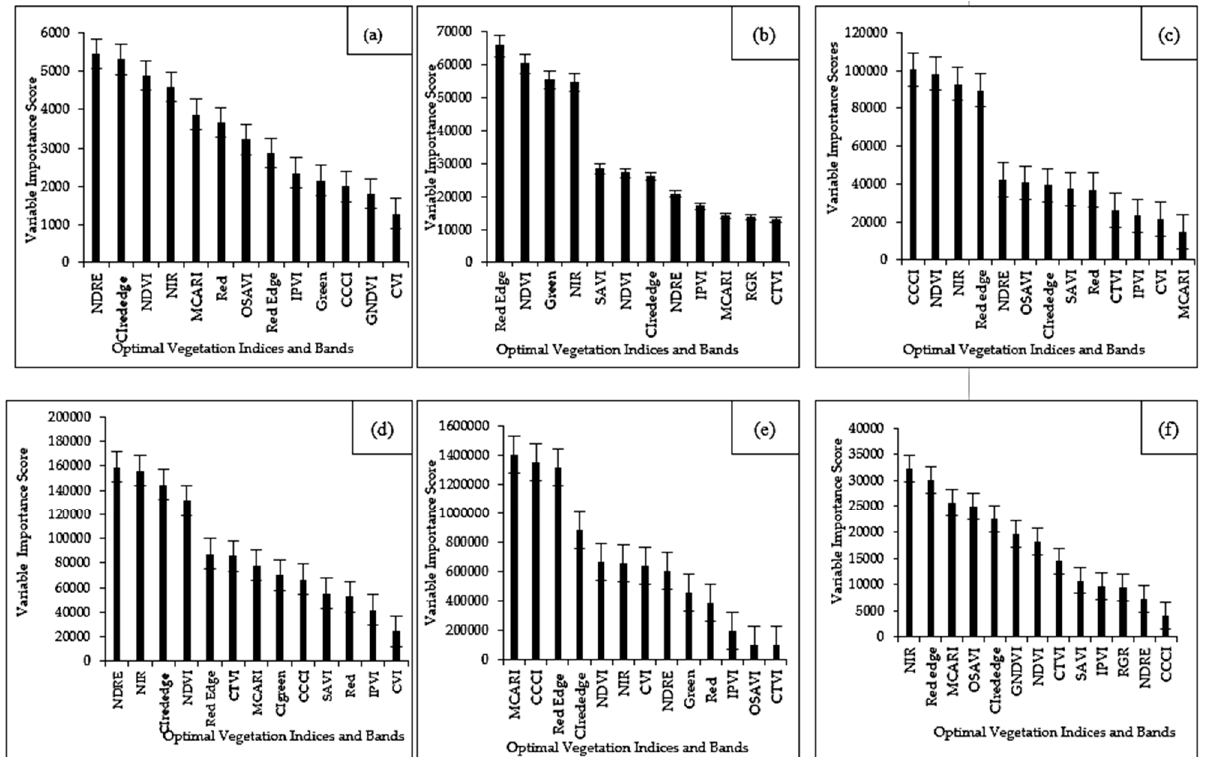
Figure 6. Variable importance scores of optimal chlorophyll content VIs and bands for vegetative stages ( a ) V5–V10, ( b ) V12, ( c ) V14 to VT, and reproductive stages ( d ) R1–R3, ( e ) R3–R4, ( f ) R5–R6.